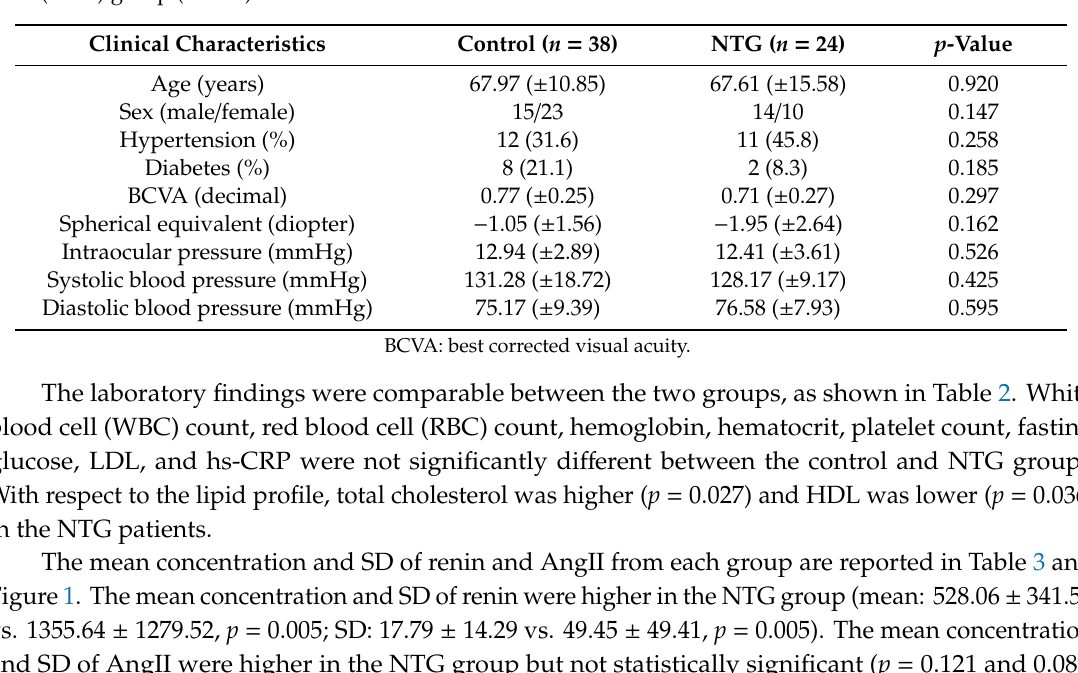
Table 1. Comparison of the clinical characteristics of the control group and the normal tension glaucoma (NTG) group ( n = 62).